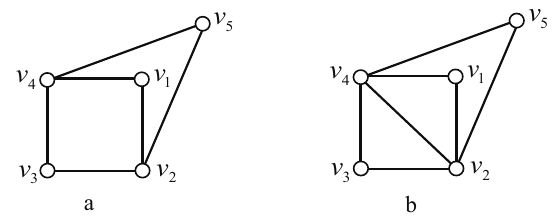
Figure 6. Vertex v 5 is exactly adjacent to two vertices of C 4 . For a , v 2 and v 4 are nonadjacent; for b , v 2 and v 4 are